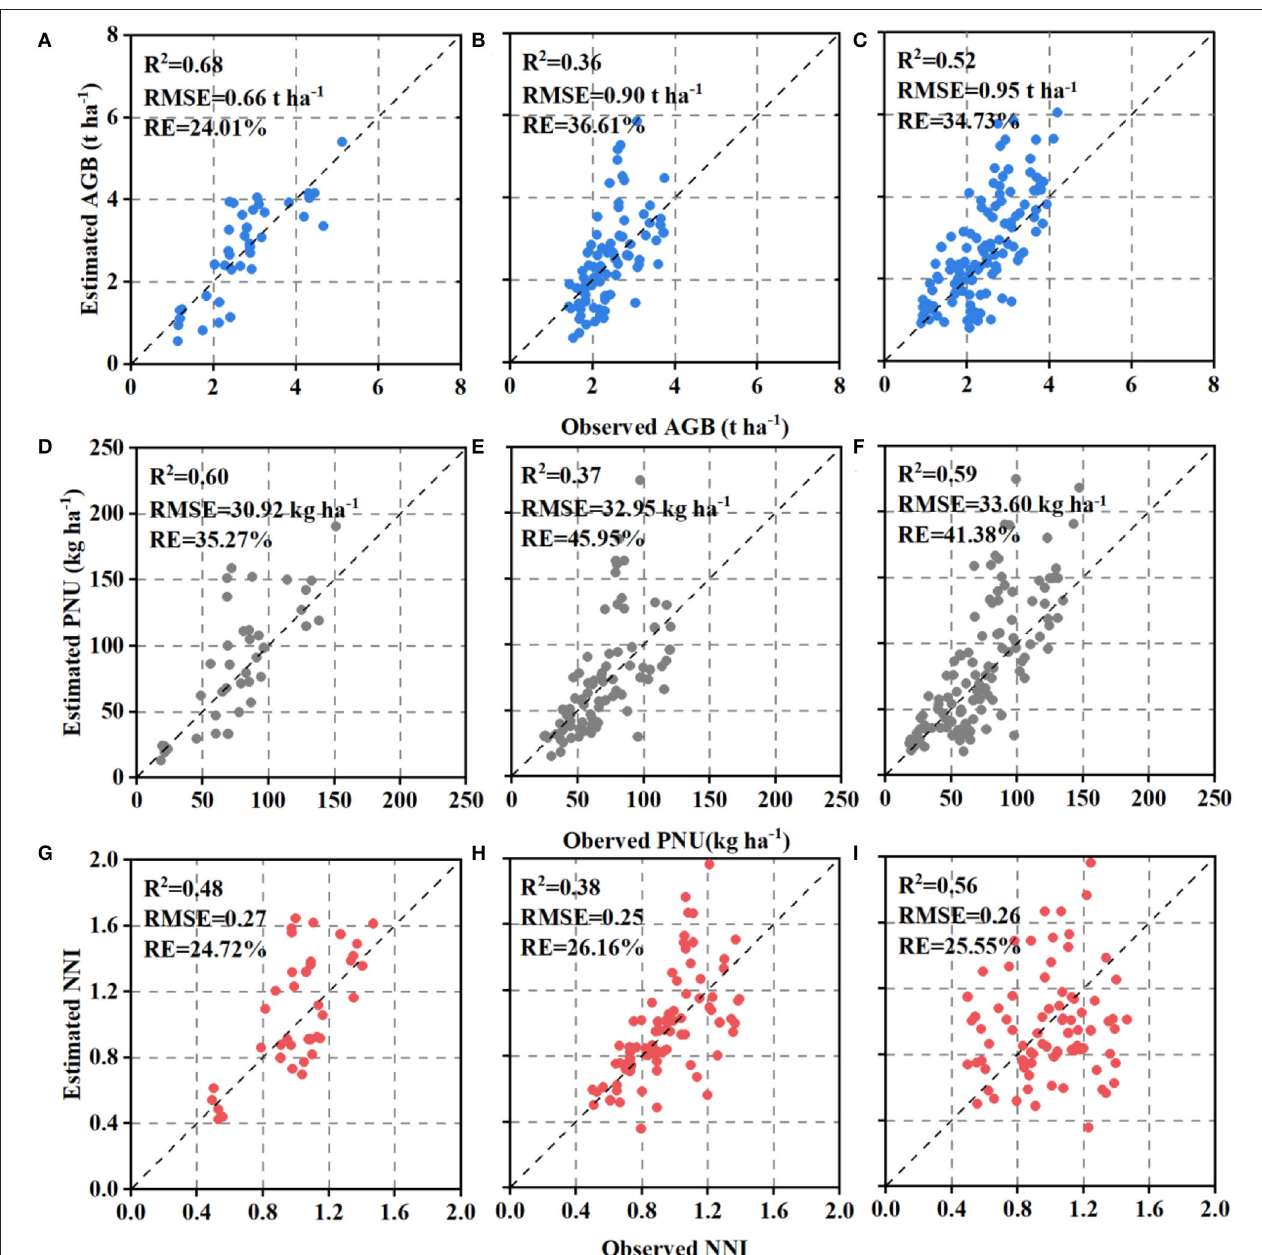
FIGURE 4 | Relationships between estimated and observed aboveground biomass (AGB), plant N uptake (PNU), and N nutrition index (NNI) using simple linear regression on the test dataset in agro-ecological zone 1 (A,D,G) , agro-ecological zone 2 (B,E,H) and two agro-ecological zones (C,F,I) . The black dotted line is the 1:1